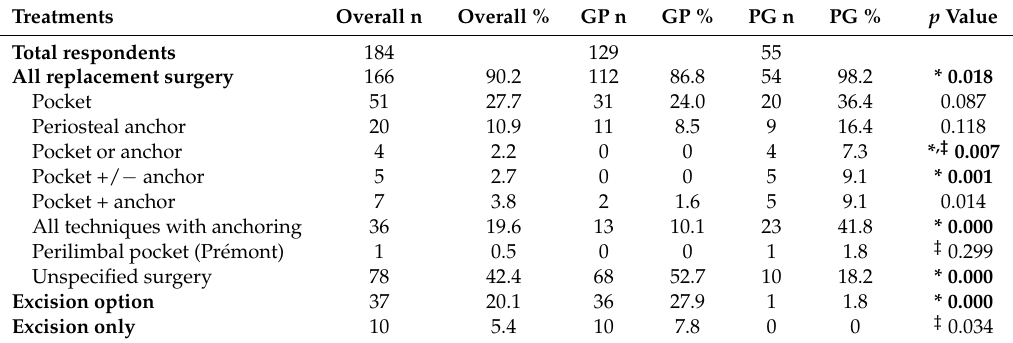
Table 4. Canine PNG surgical failure treatments recommended by GP and PG groups responding to a vignette questionnaire.